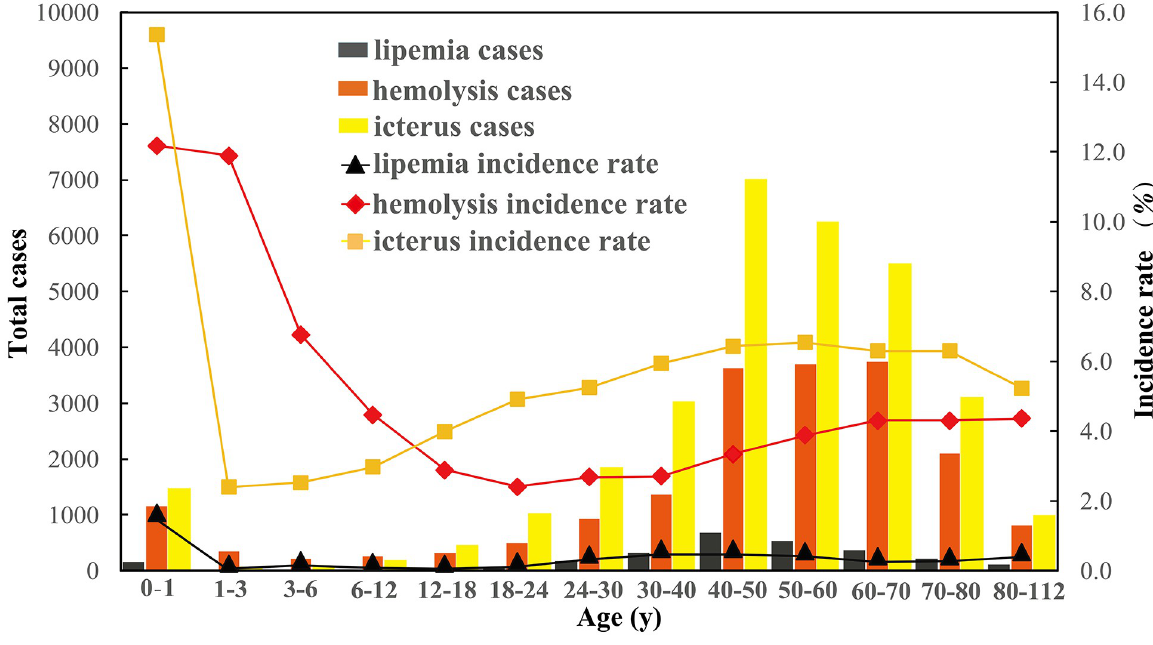
Fig 4. The influence of age on HIL incidence (n =